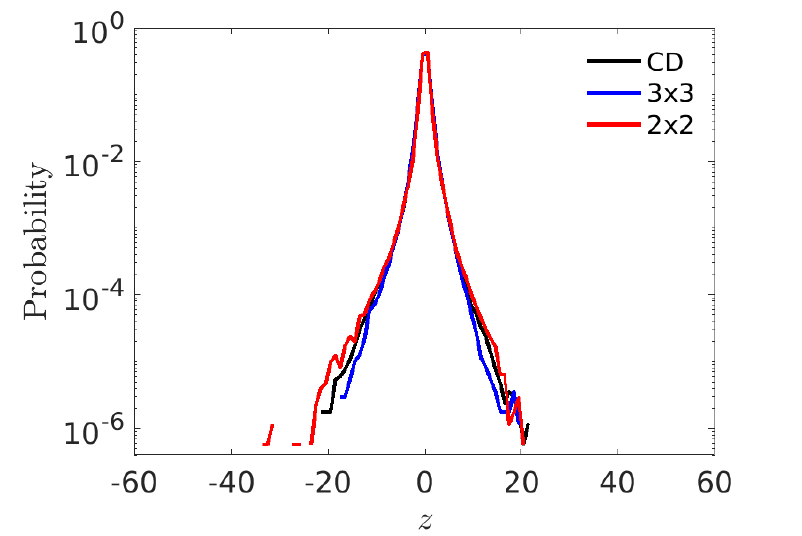
Figure A1. Effect of numerical method on probability distributions P ( δ ) calculated using standard central differences (CD 3-by-3, black), and difference-then-average (CDA 3-by-3, blue; CDA 2-by-2, red). Probability distributions are plotted in standardized coordinates, z = ( δ − δ ) / σ δ , where δ and σ δ are mean and standard deviation of δ ,